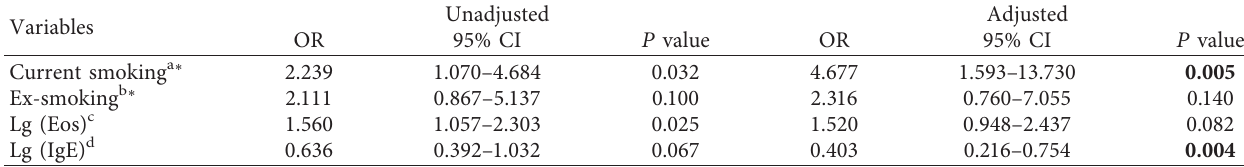
Table 3: Association between Th2 biomarkers, smoking status, and small airway obstruction.